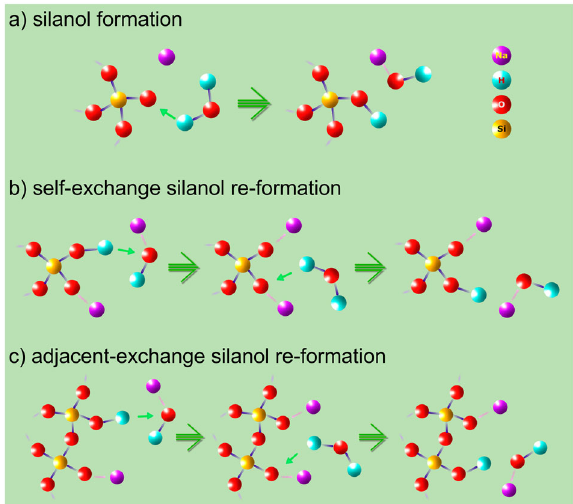
Fig. 12 Schematics of the three types of ion-exchange processes during the sodium silicate glass – water interfacial reactions. a Silanol formation, b self-exchange silanol re-formation, c adjacent- exchange silanol re-formation. The small green arrows indicate the target directions of the proton movement. The purple, cyan, red, orange circles represent for the sodium, hydrogen, oxygen, and silicon atoms,